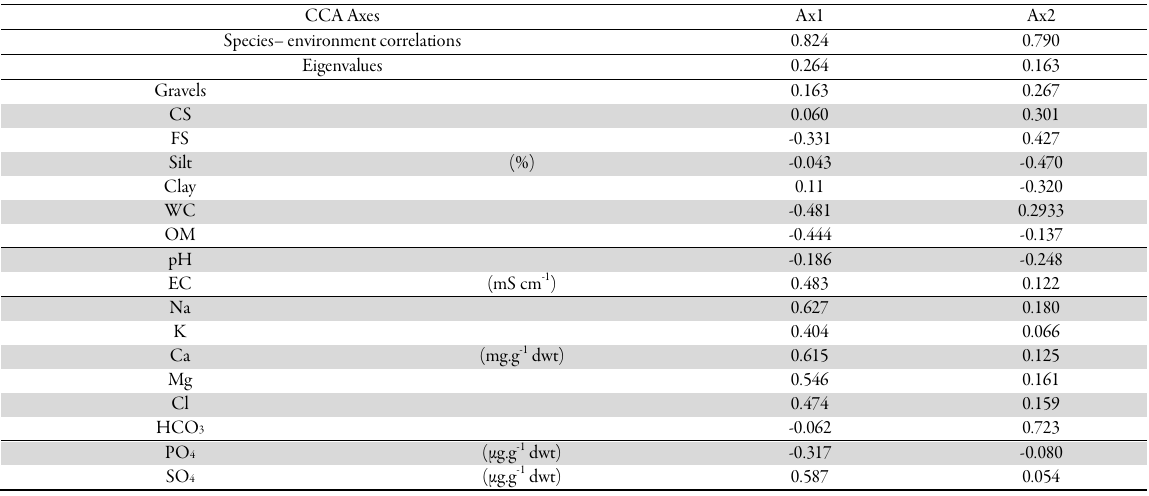
Table 3. Interset correlation of CCA analysis for the soil variables, together with eigenvalues and species–environment correlations (for soil abbreviations, see Table 2)